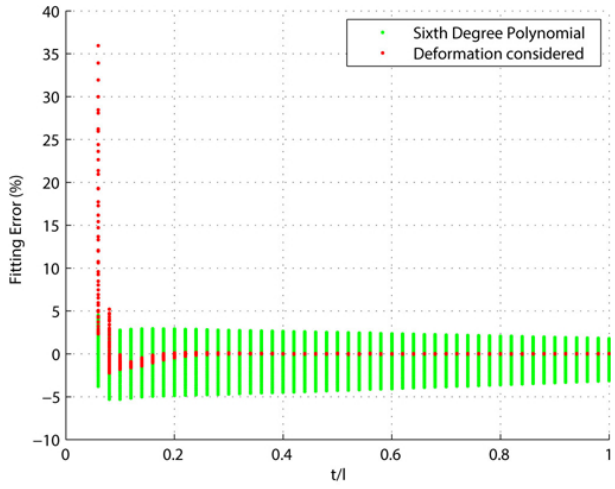
Table 1. Coe ffi cients for Eqs. (1), (2), (3), and